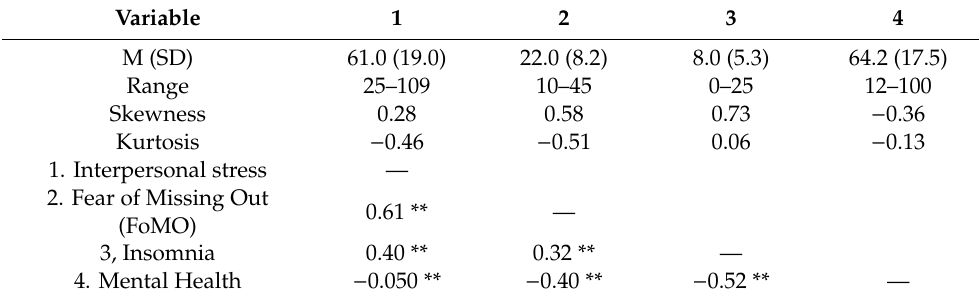
Table 1. Mean, standard deviations, scale ranges, and Zero Order Correlations of Study Variables.